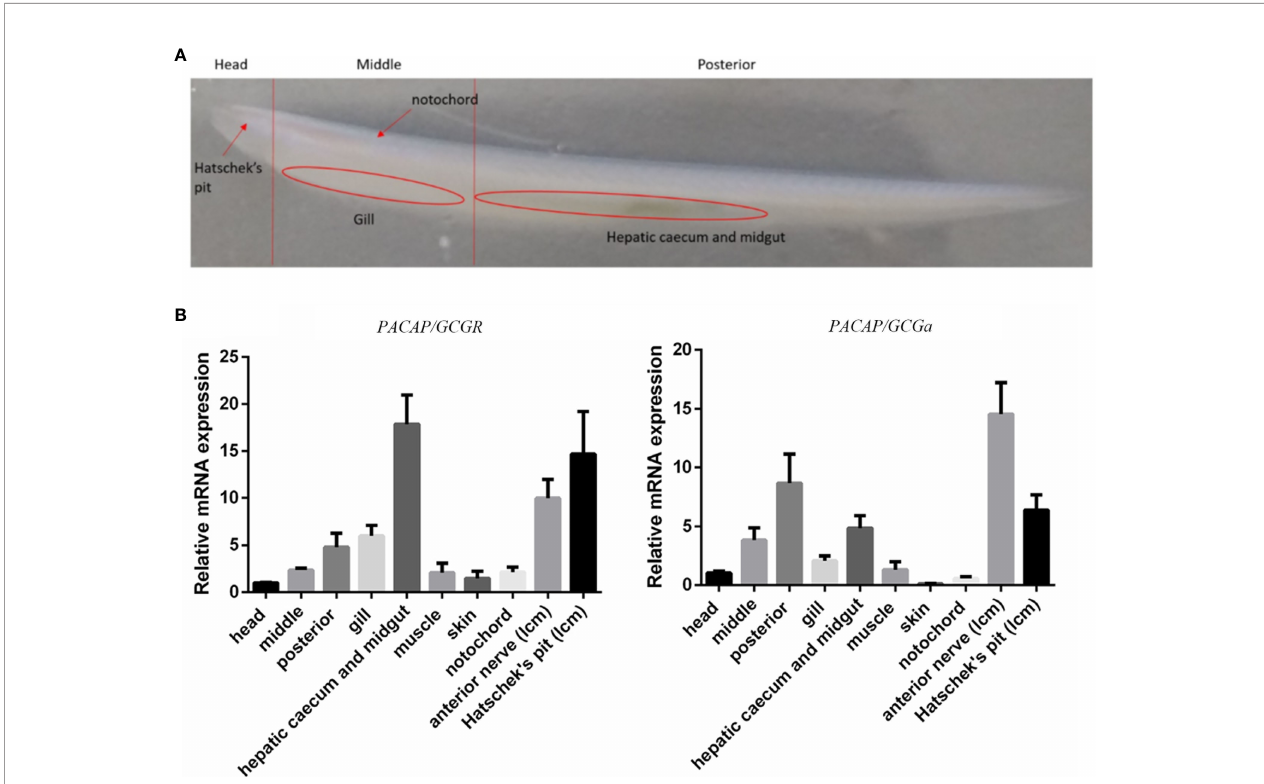
FIGURE 2 | Expression pro fi le of the PACAP/GCGa and PACAP/GCG-R transcripts in adult B . belcheri . (A) Representative image of a whole adult individual indicating the localization of the collected tissues for expression analysis. (B) Relative expression of PACAP/GCGa and PACAP/GCG-R in the head (without the gills), middle part (without hepatic caecum), posterior part (with hepatic caecum and midgut), gills, hepatic caecum and midgut, muscle, skin, notochord, anterior nerve (LCM), and Hatschek ’ s pit (LCM). Melting curves for each transcript in qRT-PCR are all a single peak. Data is expressed as means ± SEM ( n =